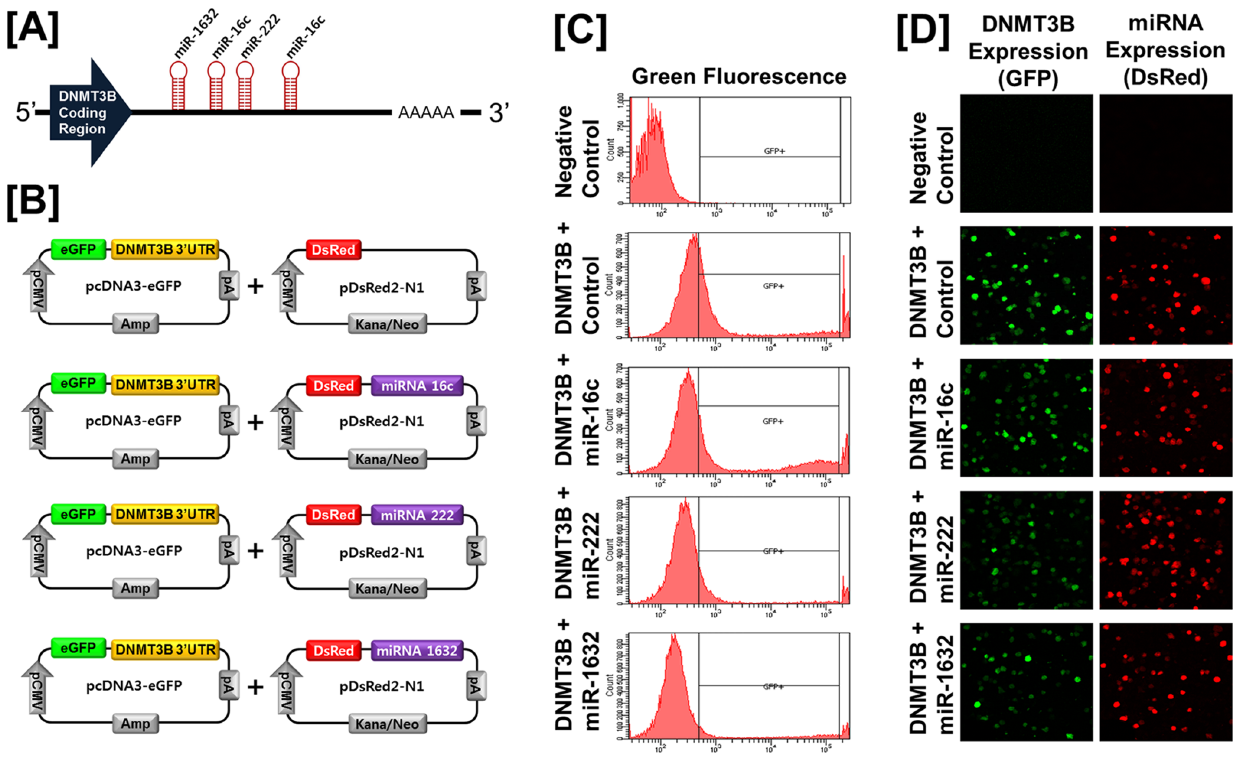
Figure 4. In vitro target assay of microRNAs on the DNMT3B transcript. [A] Diagram of miR-16c , miR-222 , and miR-1632 binding sites in the DNMT3B 3 9 -UTR. [B] Expression vector map for eGFP with DNMT3B 3 9 -UTR and Ds-Red with each miRNA. [C and D] After co-transfection of pcDNA- eGFP-3 9 -UTR for the DNMT3B transcript and pcDNA-DsRed-miRNA for the miR-16c , miR-222 , and miR-1632 , the fluorescence signals of GFP and DsRed were detected using FACS [C] and fluorescent microscopy [D].